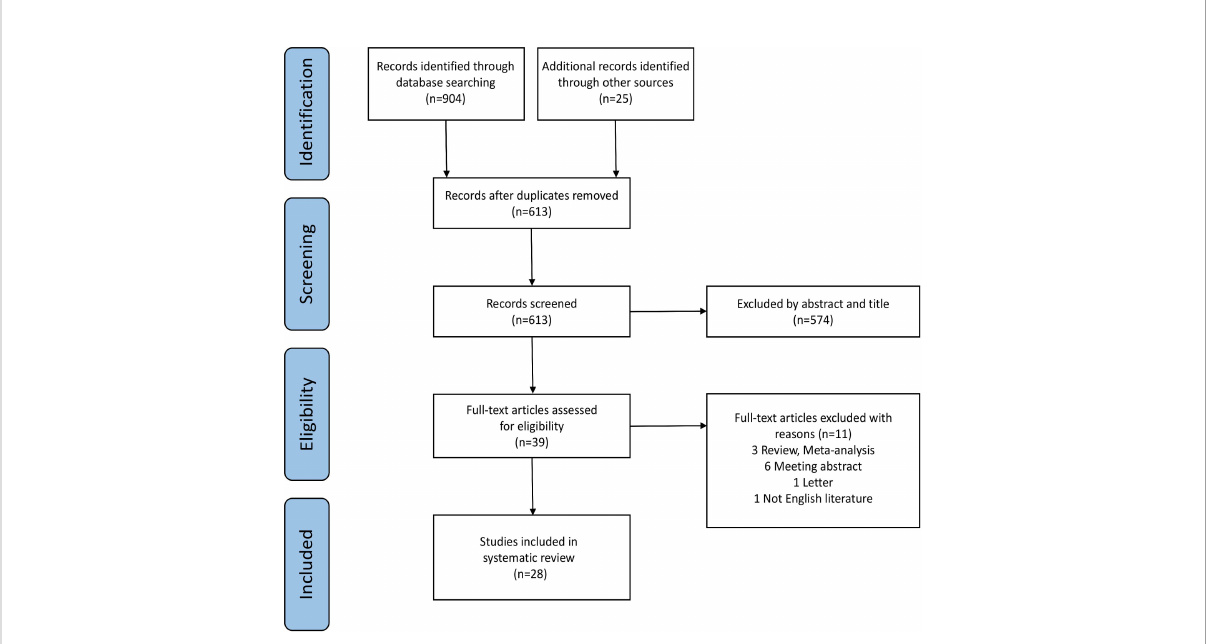
FIGURE 1 Flow diagram of study